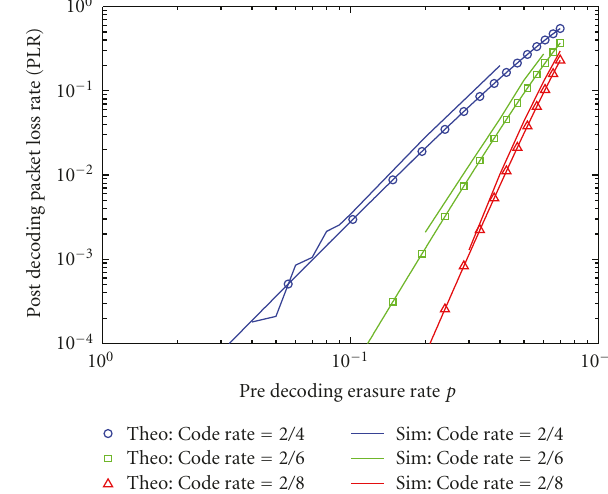
Figure 2: Packet loss rate for systematic codes with k = 2 but di ff erent d min